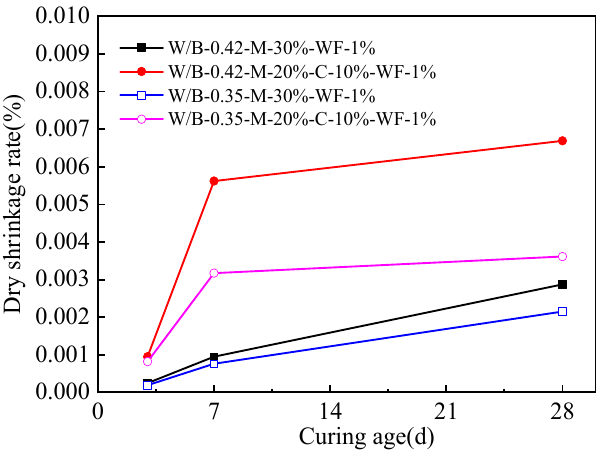
Figure 6. The shrinkage rate of reactive powder concrete.